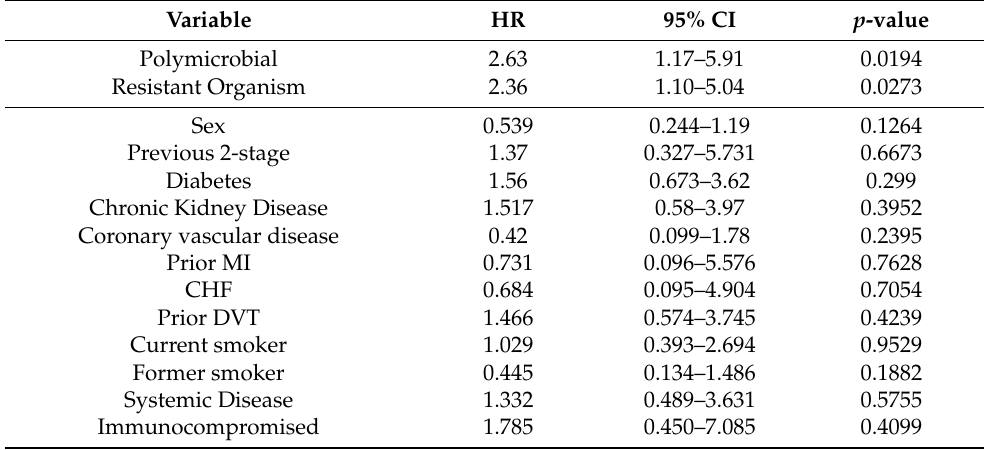
Table 3. Associated and non-associated variables. Abbreviations. MI: myocardial infarction, CHF: congestive heart failure, and DVT: deep vein